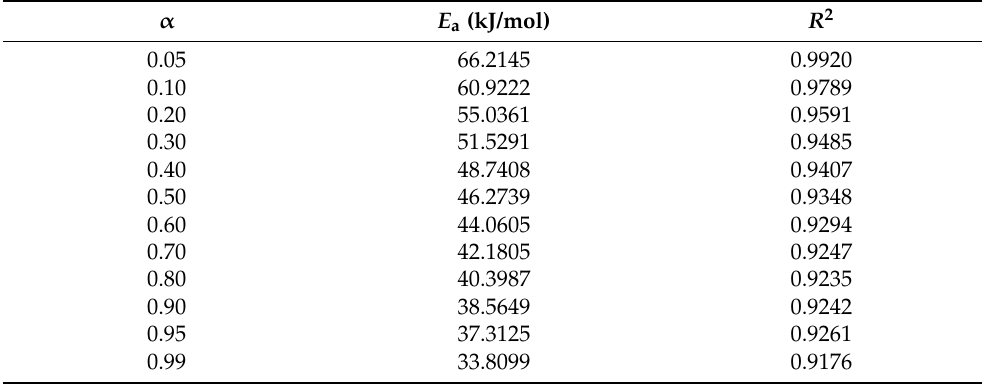
Figure 9. In the DSC experiment, differential analysis of PSS + (NH 4 ) 2 SO 4 under Vyazovkin model. Table 4. E a and R 2 under different α based on the KAS model.